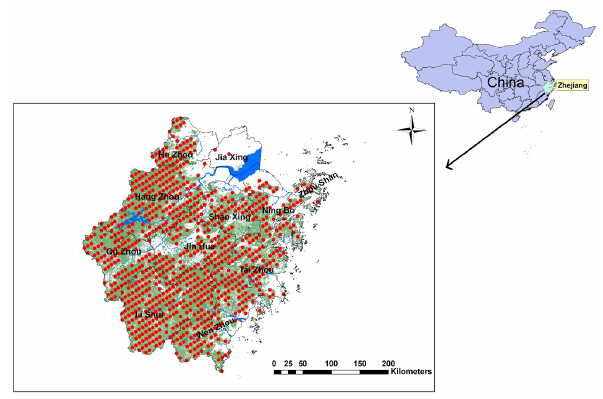
Fig. 1. Location of the study area and Fig. 1 Location of the study area and samples